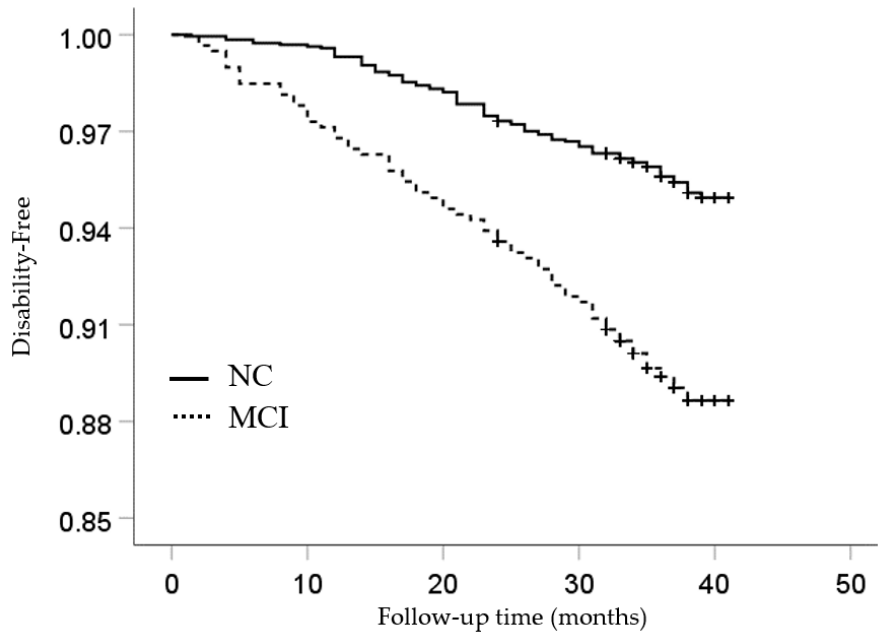
Figure 1. Kaplan–Meier survival estimates by cognitive status groups. Note: Those participants who had NC had a higher probability of being disability-free than those who had MCI. Table 2. Baseline characteristics of study participants by cognitive status. Variable